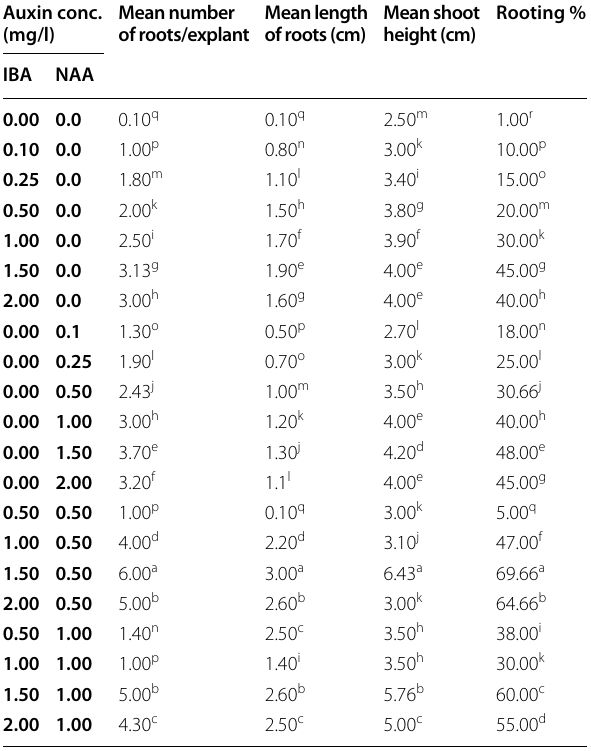
with or without Table 5 Effect of various concentrations and combinations of 3 IBA and NAA, on rooting of Dimocarpus longan